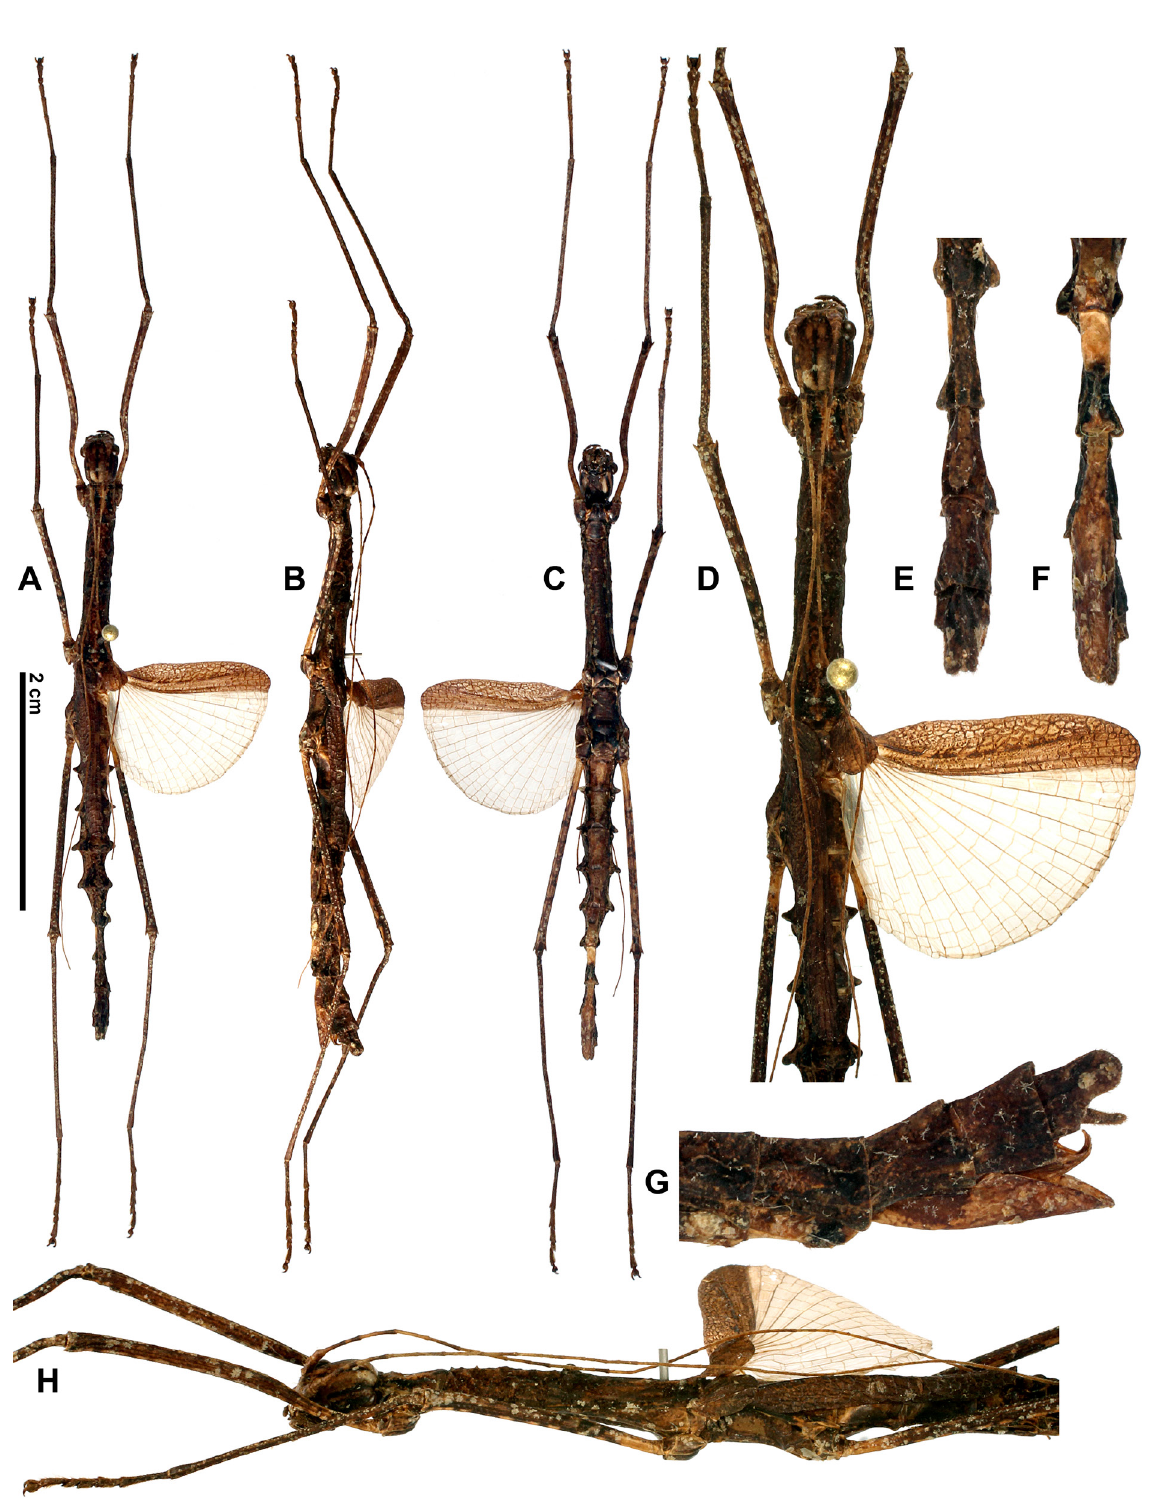
Fig. 9. Otraleus christianae sp. nov., ♀, paratype. A . Habitus, dorsal view. B . Habitus, lateral view. C . Habitus, ventral view. D . Anterior part of body, dorsal view. E . Apex of abdomen, dorsal view. F . Apex of abdomen, ventral view. G . Apex of abdomen, lateral view. H . Anterior part of body, lateral view. D–H: not to